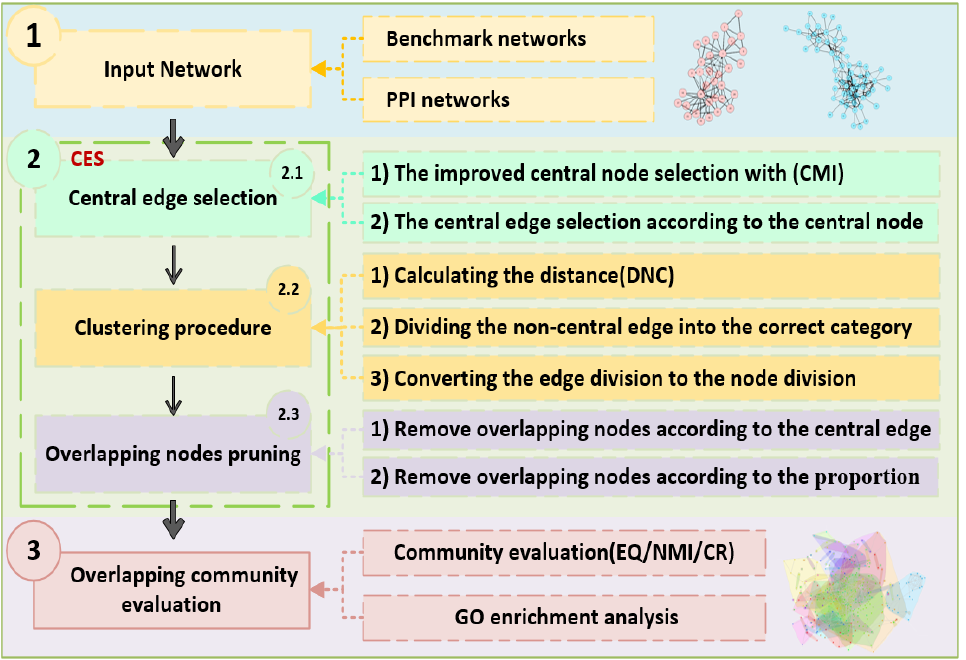
Figure 2. Workflow of the CES algorithm.